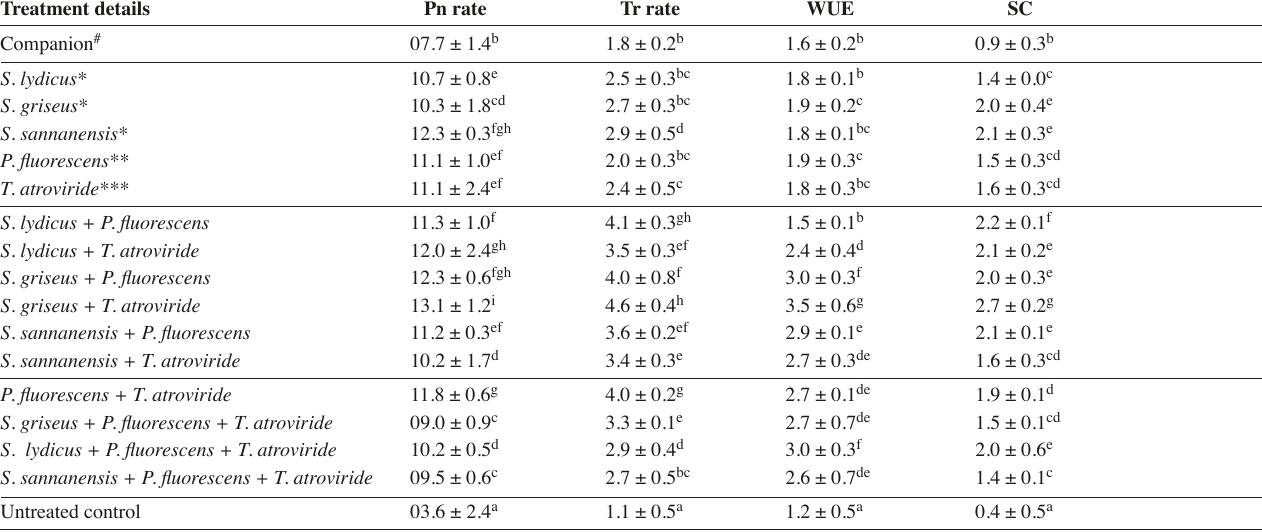
Tab. 4: Effect of various biocontrol agents and fungicide on physiological variations in rhizome rot disease infected turmeric plant leaves Treatment details